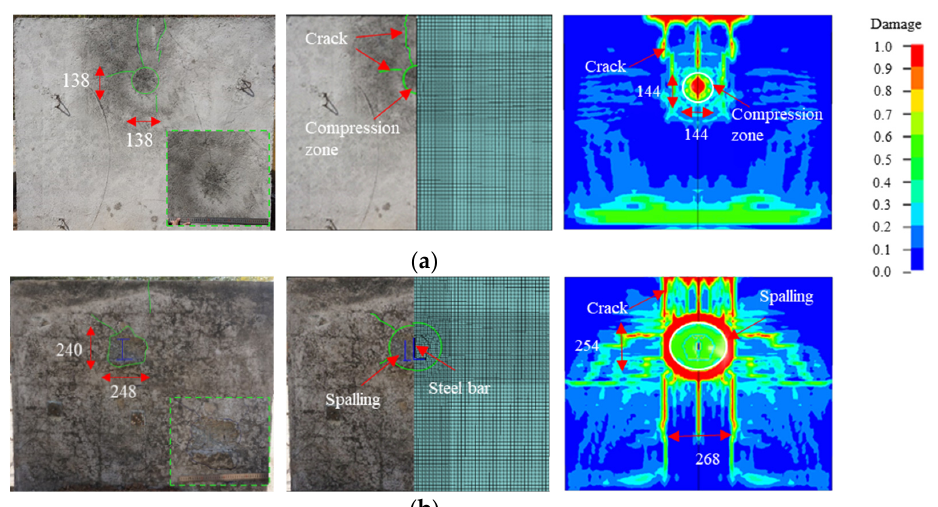
Figure 10. Experimental and simulation results of the damage of the SW wall (unit: mm): ( a ) Front side; ( b ) Back side.